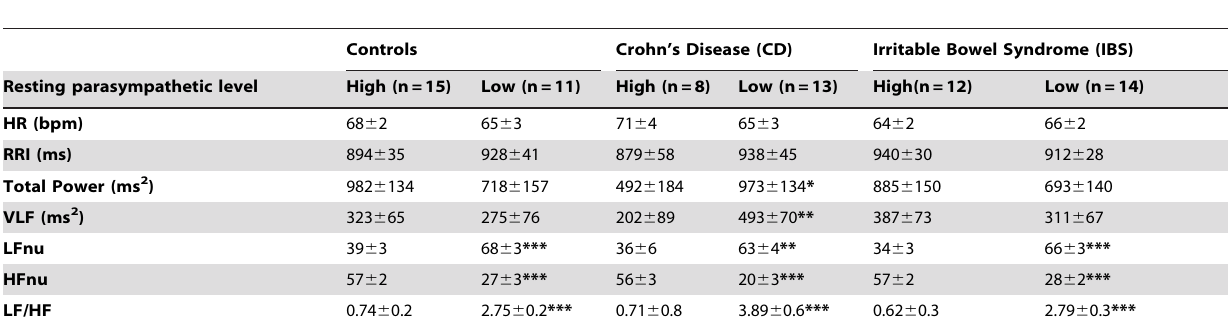
Table 2. Data representing the sub-group categorization based on HFnu-HRV K-mean classification.